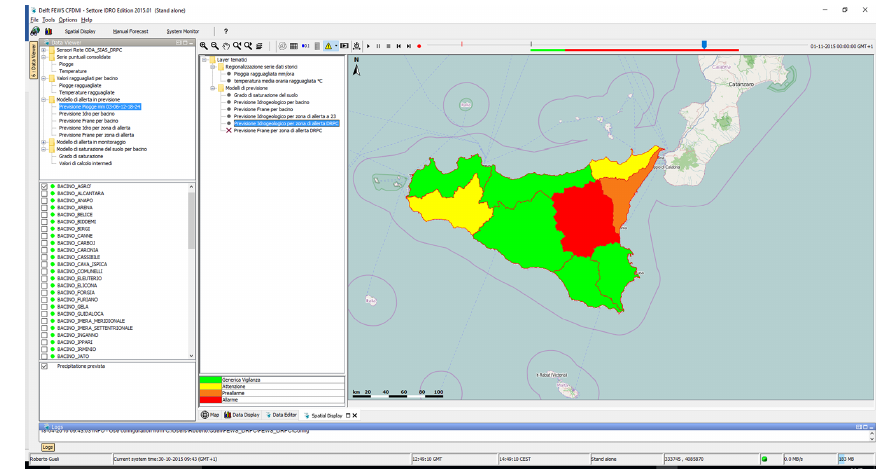
Figure 9. Example of layout coming from Delft-FEWS